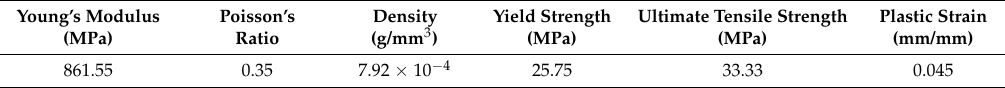
Table 1. Material properties of Acrylonitrile Butadiene Styrene (ABS) material [17].